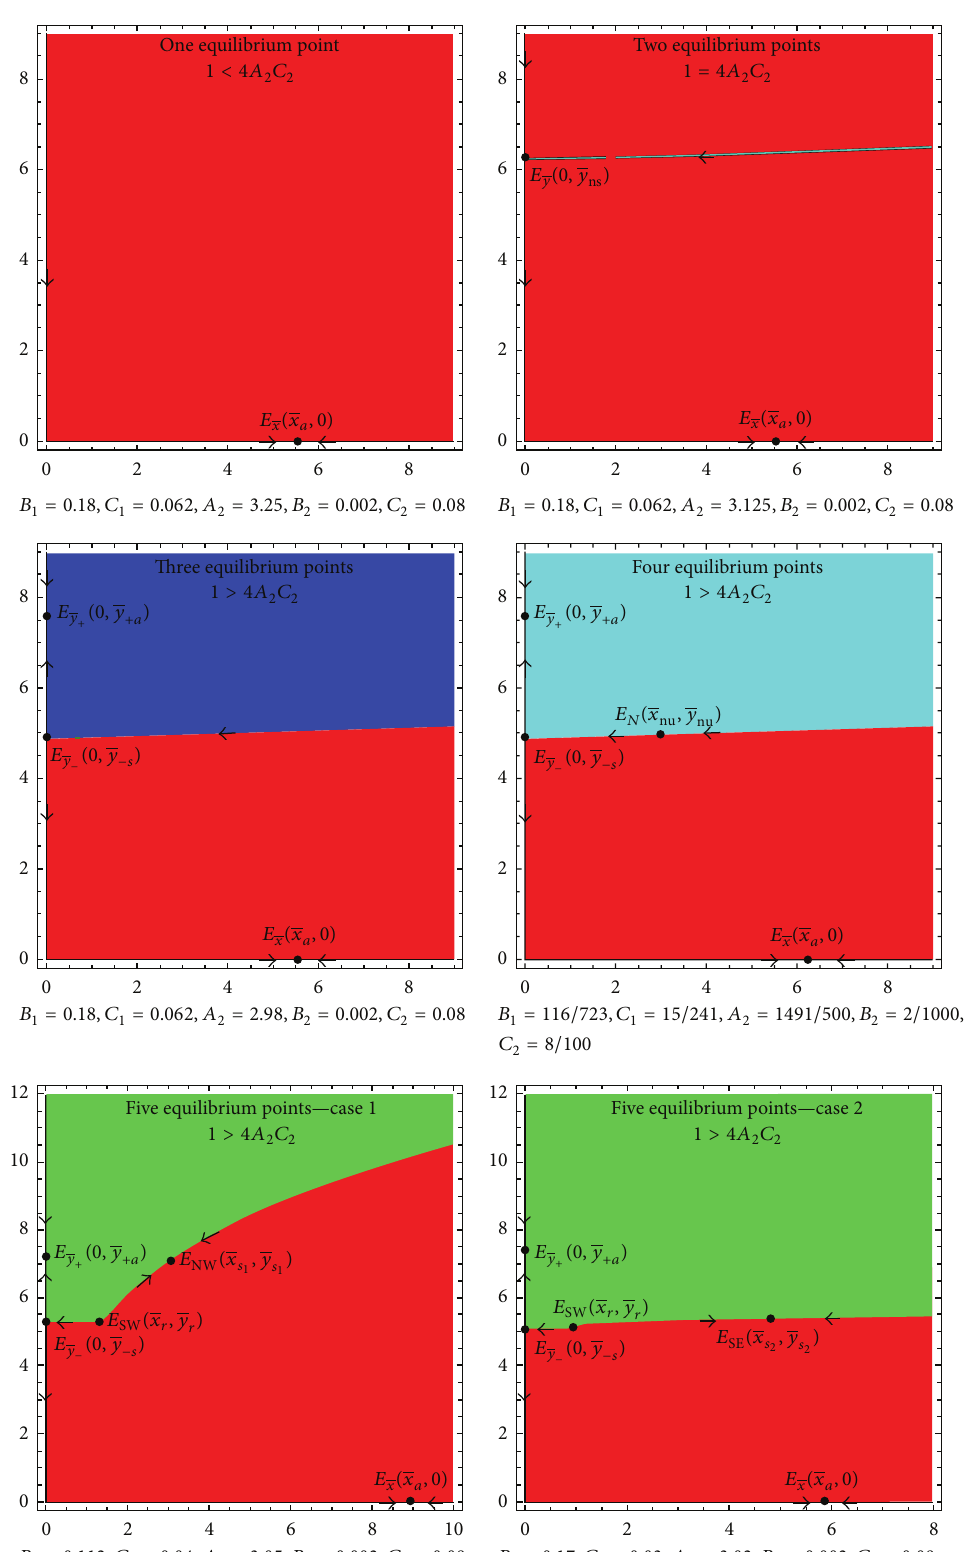
Figure 3: Global